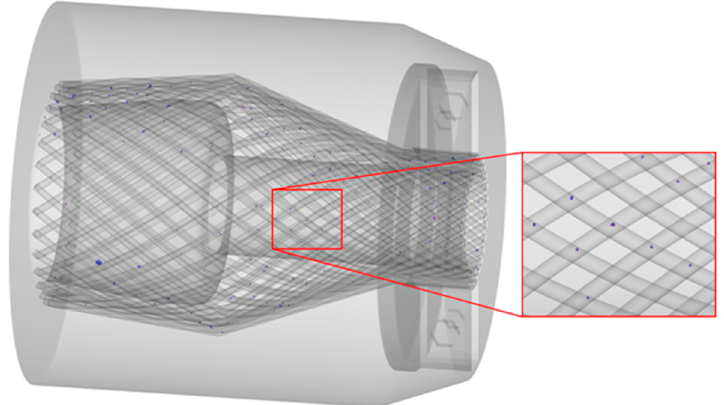
Figure 13. Air trap results after optimization of the structure and process conditions .